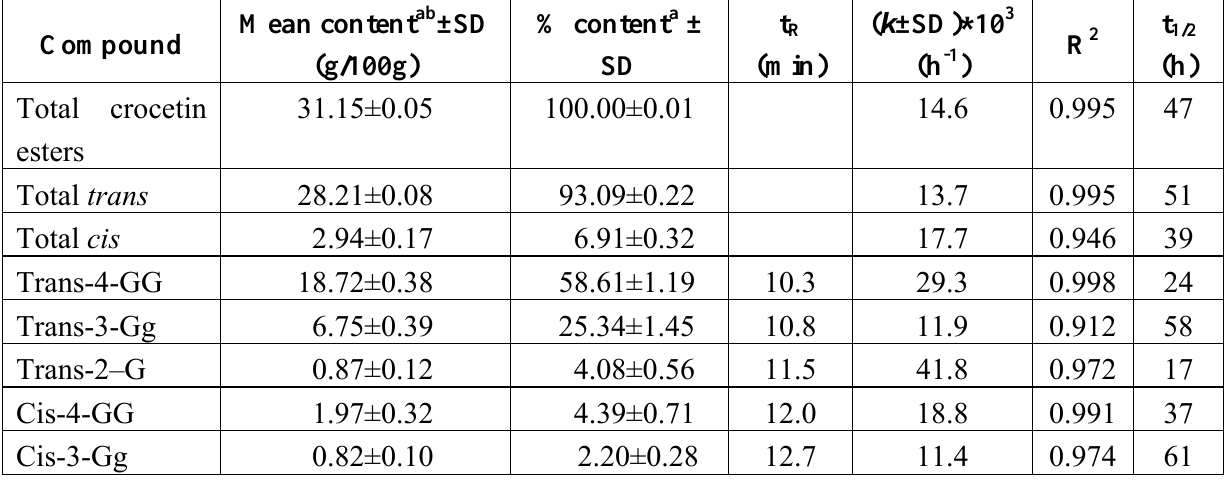
Table 1. Total and individual crocetin esters composition, retention time (t ester in saffron aqueous extract of the control